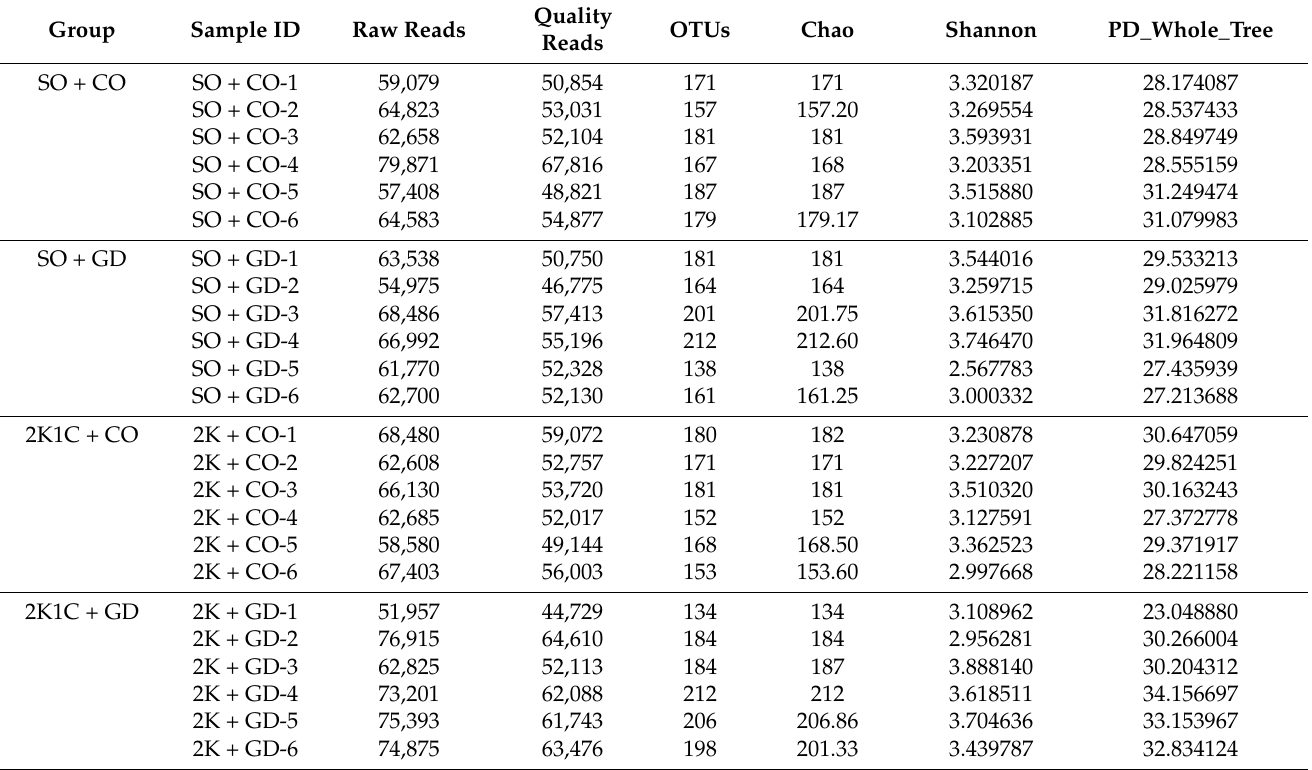
Table 1. Estimated sequencing coverage and alpha diversity indices of the bacterial taxonomic profiles of the 16S rRNA gene sequences at the genus